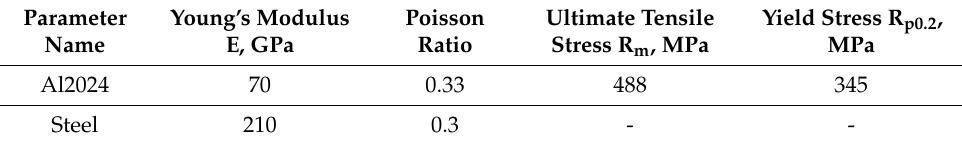
Figure 5. Shear load versus displacement of the upper node of the loading frame obtained for stiffened plates. Results from the strength test machine.